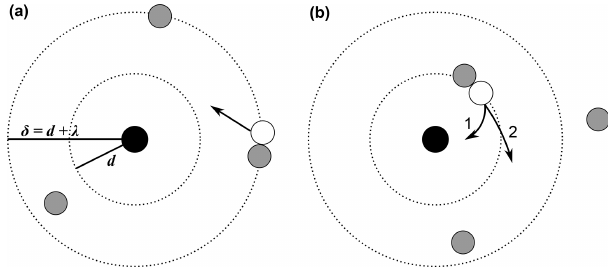
Figure 1. Schematic representation of the limiting sphere, based on Hoppel and Frick (1986), López-Yglesias and Flagan (2013), and Tamadate et al. (2020b). The black circle in the centre rep- resents an ion and the white circle represents an ion of opposite sign, while the grey circles represent neutral gas molecules. The in- ner dotted circle with the radius d is the ion–ion trapping sphere, while the outer dotted circle with the radius δ = d + λ describes the limiting sphere. The spheres are defined differently in various theories; this schematic representation depicts the theory of Hop- pel and Frick (1986). (a) The approaching white ion experiences its last collision with a neutral gas molecule outside the ion–ion trapping sphere, here, one mean free path away from the surface of the trapping sphere. (b) The white ion collides with another neutral gas molecule, this time leading to it entering the trapping sphere, i.e. being “trapped”. In case 1, it collides and subsequently recom- bines with the black ion of opposite sign. In case 2, no ion–ion colli- sion and recombination occur and the white ion leaves the trapping